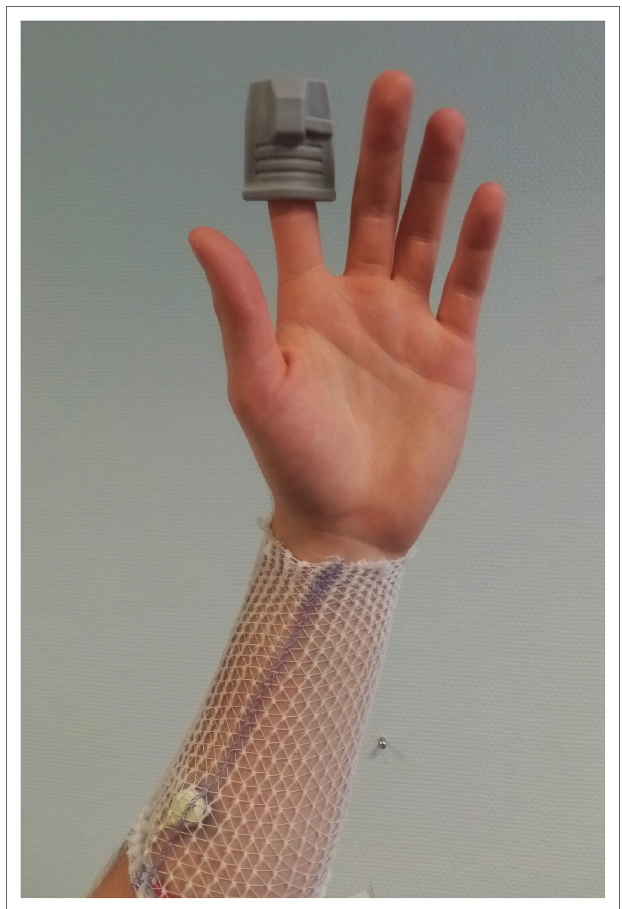
FIGURE 2 | Positions of the photo-plethysmographic probe on the finger and of the transcutaneous oximetry sensor on the forearm of one subject. As shown, a surgifix ® net was used to stabilize the sensors and hold the wires in